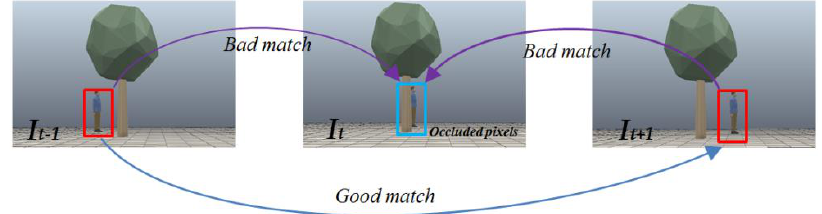
Figure 3. Occlusion error during reprojection.